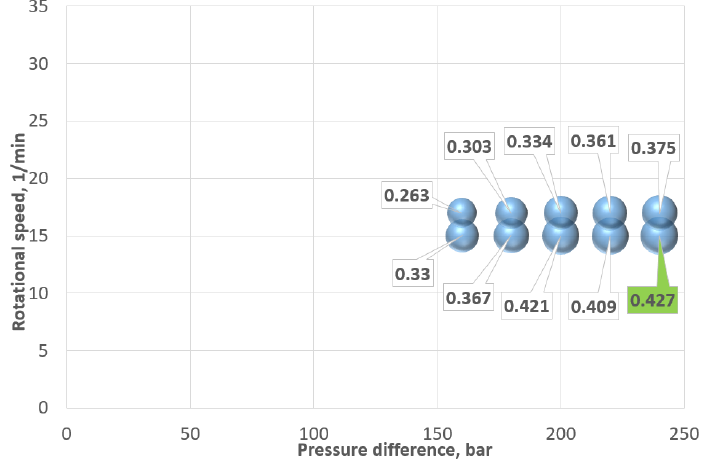
Figure 6. Total efficiency (value in label) of the original hydraulic motor, with hole size in valve plate φ = 5.5mm, tested in oil.